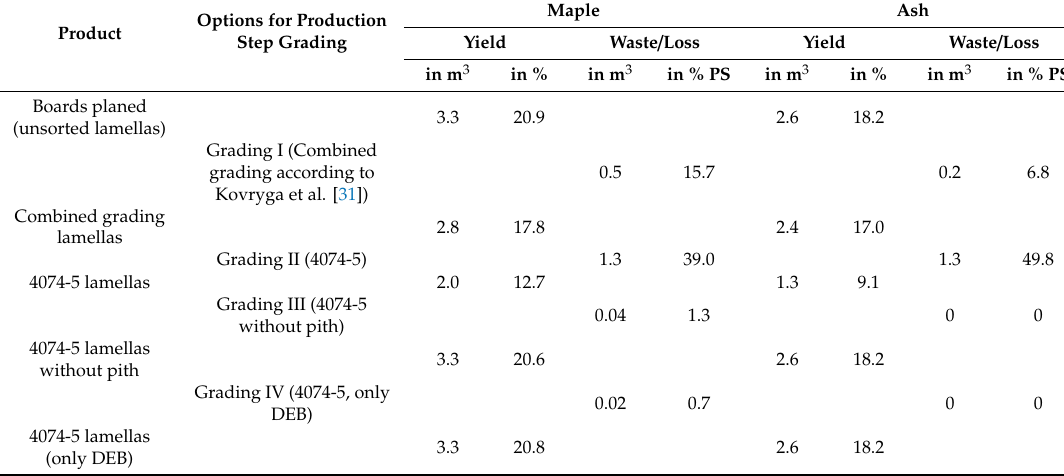
Table 8. Volume yields for the production step grading (from planed board to graded lamella) for four di ff erent grading